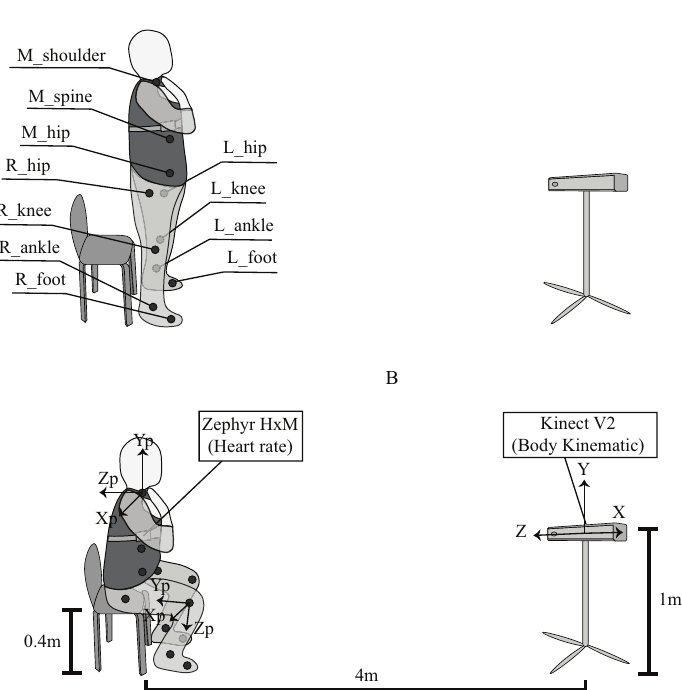
Figure 2. Set-up of the study and sit-to-stand representation, ( A ) standing position and ( B ) sitting